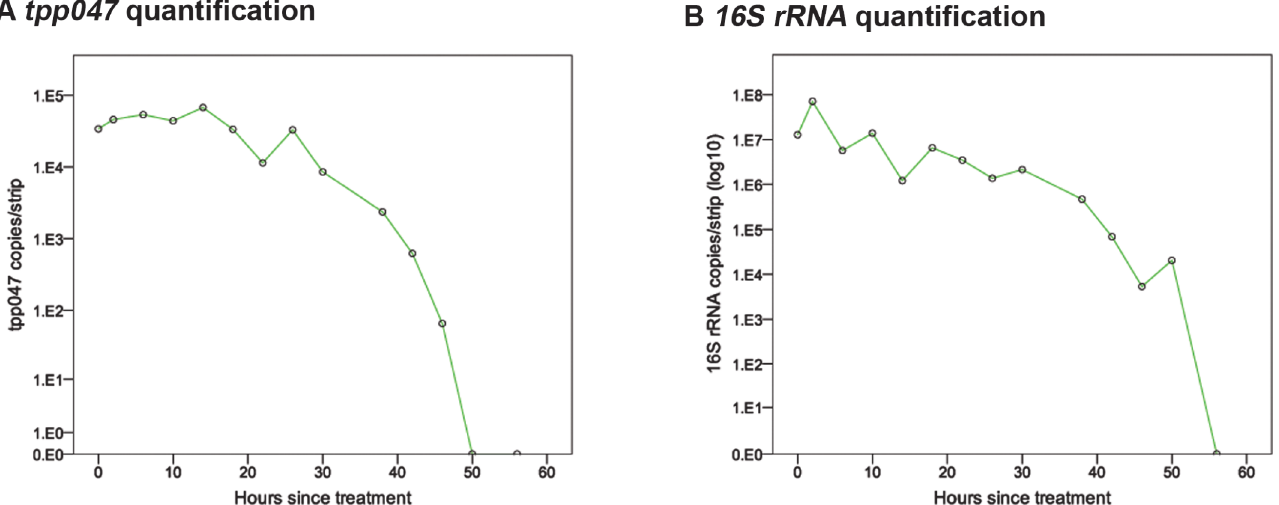
Fig 2. A patient presenting with a DGM positive penile ulcer (primary syphilis) was administered a 2.4 megaunit dose of benzathine penicillin at time zero. Ulcer samples for T. pallidum DNA and RNA quantification were collected pre-treatment and then four hourly for 56 hours. Panel A . presents DNA ( tpp047 ) decay and Panel B . shows 16S rRNA decay.